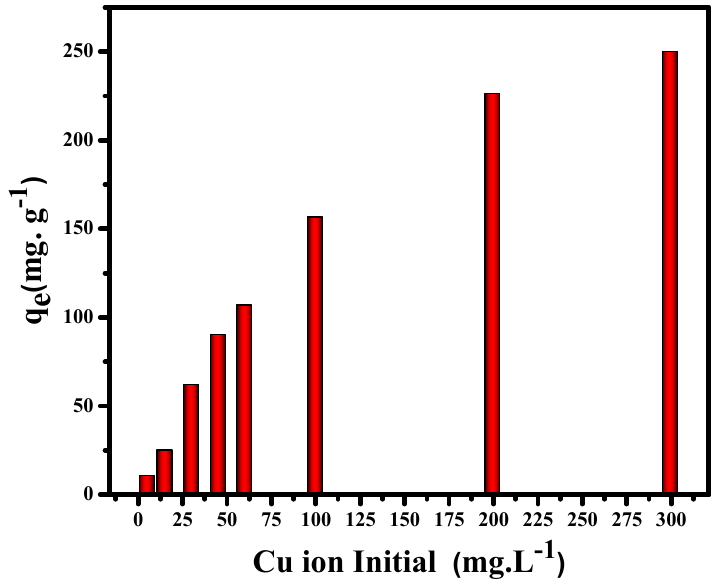
Figure 3. Variation of adsorption capacity of Cu (II) with the initial concentration (conditions: 25 °C; adsorbent dosage: 10 mg; stirring speed: 400 rpm; contact time: 24 h; initial Cu (II) concentration: 5– 300 mg/L, pH = 7).